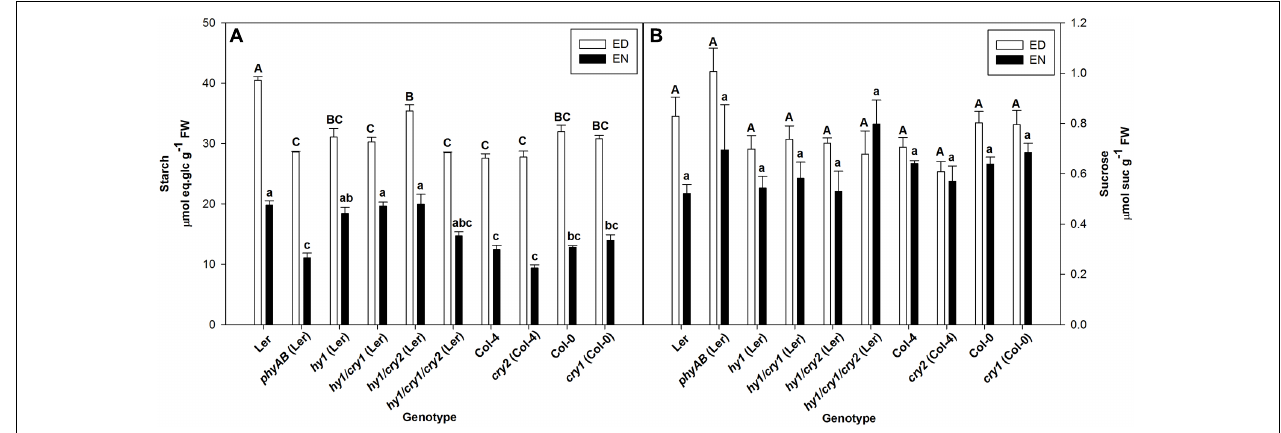
FIGURE 1 | (A,B) Starch and sucrose contents at ED and EN in photoreceptor mutants and their respective WTs. Plants were grown under FL2 with PPFD of 115 ± 5 µ mol m − 2 s − 1 . Results are mean ± SE of measurements made on five biological replicates. Significant differences ( p < 0.05) are indicated by different letters, uppercase for ED, and lowercase for EN.